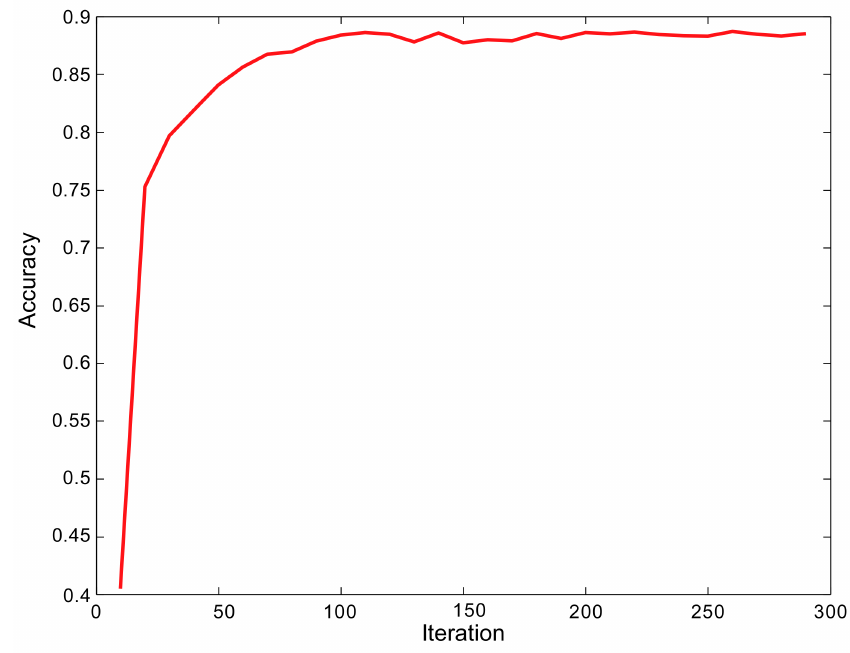
Figure 6. The accuracy curve during the training